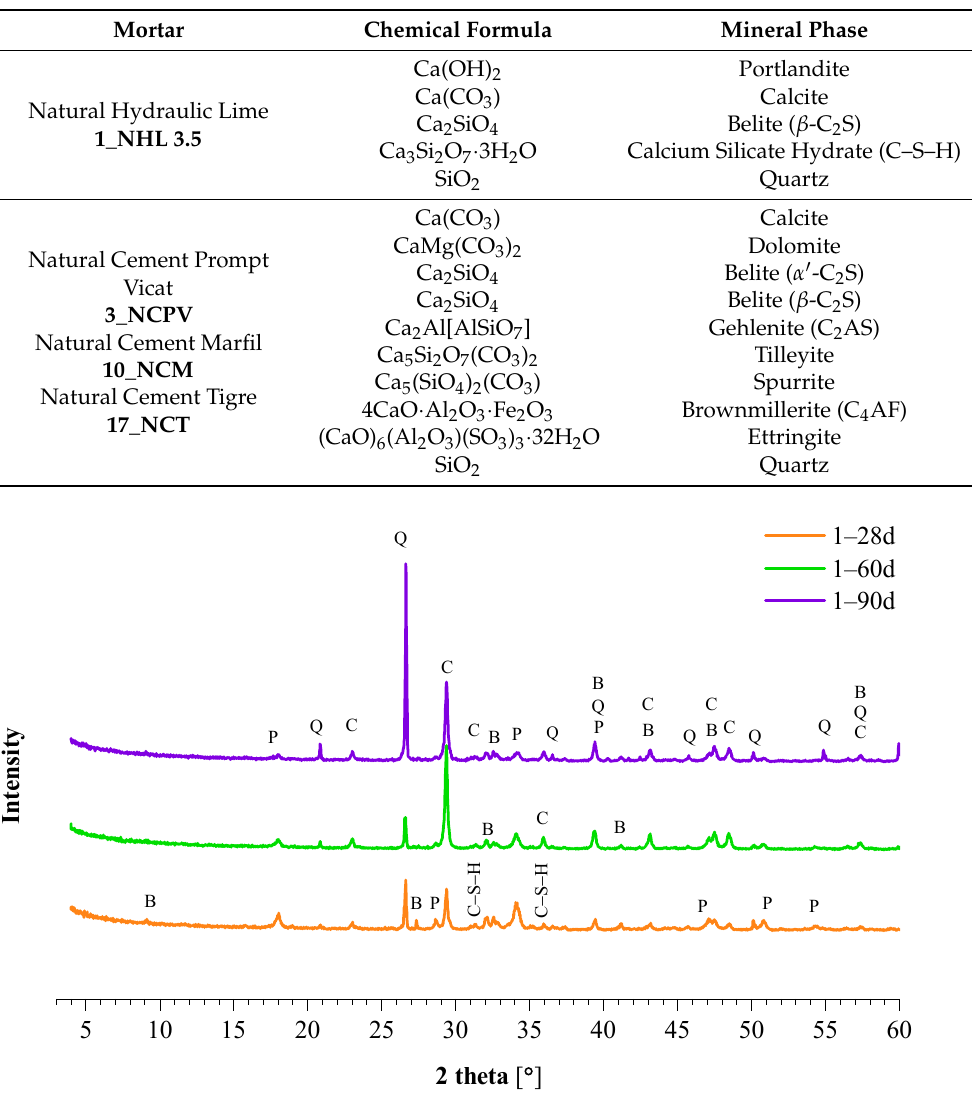
Figure 2. XRD analysis of 1_NHL mortar. B—belite, C—calcite, C–S–H—calcium silicate hydrate, P—Portlandite, Q—quartz.